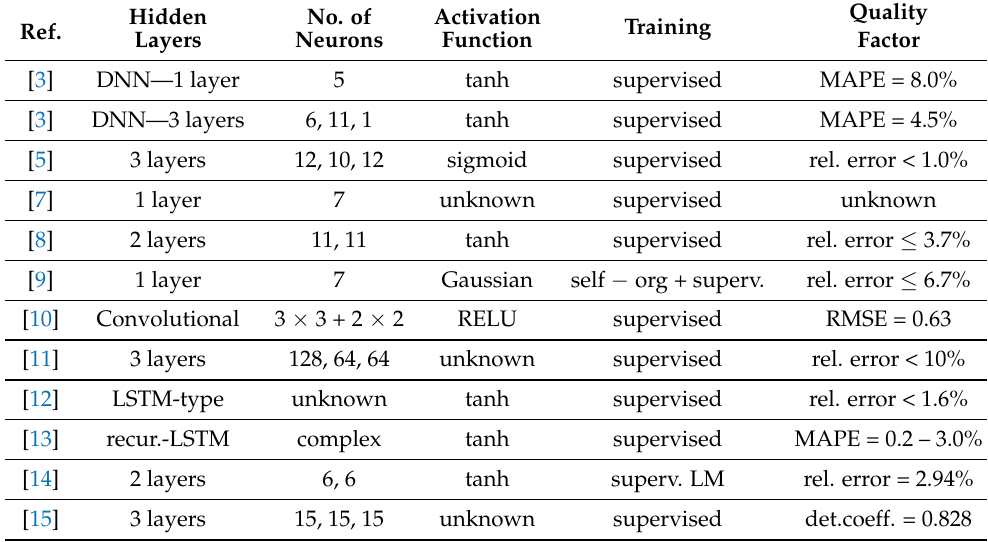
Table 1. Parameters of neural networks designed for prediction.